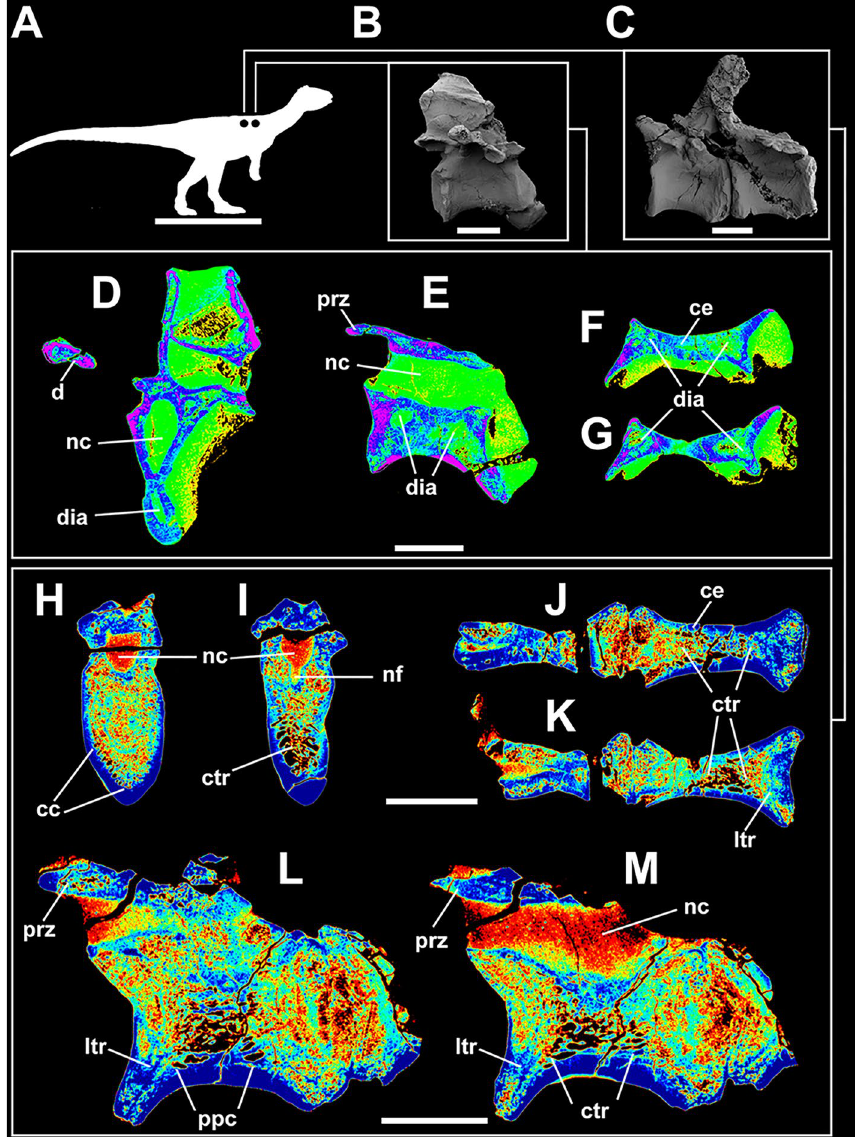
Figure 6. Micro-computed tomography of the vertebrae of the early sauropodomorph Pampadromaeus (ULBRA-PV016). ( A ) silhouette shows the position of the axial elements. Artist: Felipe Elias. ( B ) 3D reconstruction of the mid-dorsal vertebra and the correspondent high-contrast density slices in ( D – G ). Diagenetic artifacts significantly compromised the internal structures in this element. ( C ) 3D reconstruction of the articulated anterior dorsal vertebrae and the correspondent high-contrast density slices in ( H – M ). Note the circumferential chambers at the bottom of the centrum in ( H ). Also, note the ‘pseudopolycamerate’ architecture in ( L ). All images indicate irregular, chaotic, apneumatic architecture. All slices were taken from the approximate midshaft. Anterior views in ( D , H , I ). Right lateral view in ( E , L , M ). Ventral view in ( F , G , J , K ). cc circumferential chambers, ce centrum, ctr chaotic trabeculae, d diapophysis, dia diagenetic artifact, ltr layered trabeculae, nc neural canal, nf nutritional foramen, ppc ‘pseudopolycamerate’ architecture, prz prezygapophysis. Scale bar in ( A ) = 500 mm; in ( B – M ) = 10 mm. Computed tomography data processed with 3D Slicer version 4.10. Figures were generated with Adobe Photoshop CC version 22.5.1